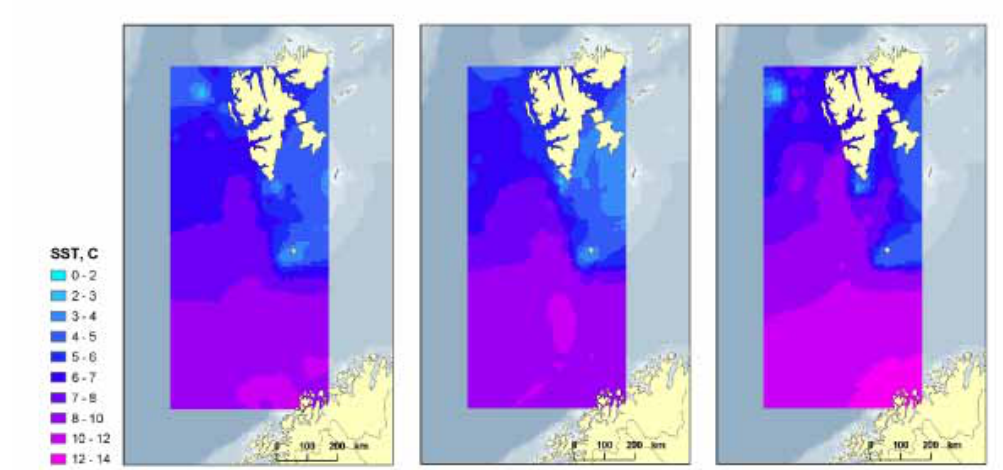
Fig. 2. Interpolated raster map of sea surface temperature (°C) in 2000, 2001 and